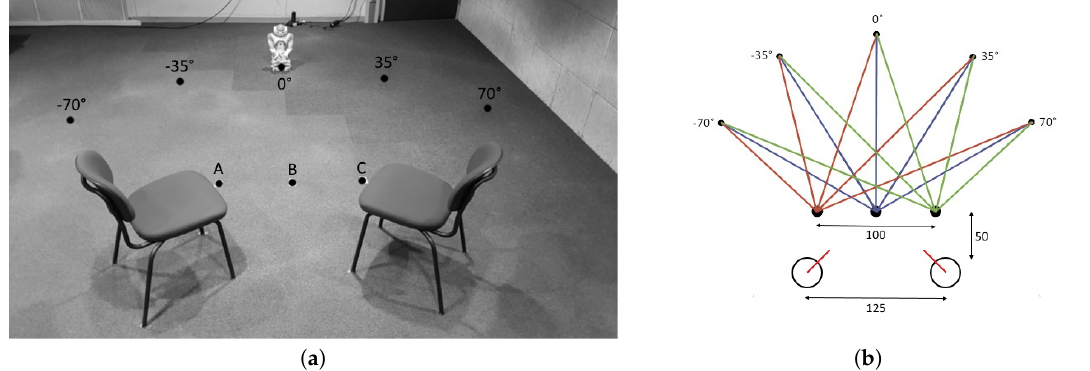
The two chairs are placed in an L-shape formation. The starting points of the robot are indicated with black dots on the circular plane around the chairs. The target locations of the robot are indicated with black dots between the